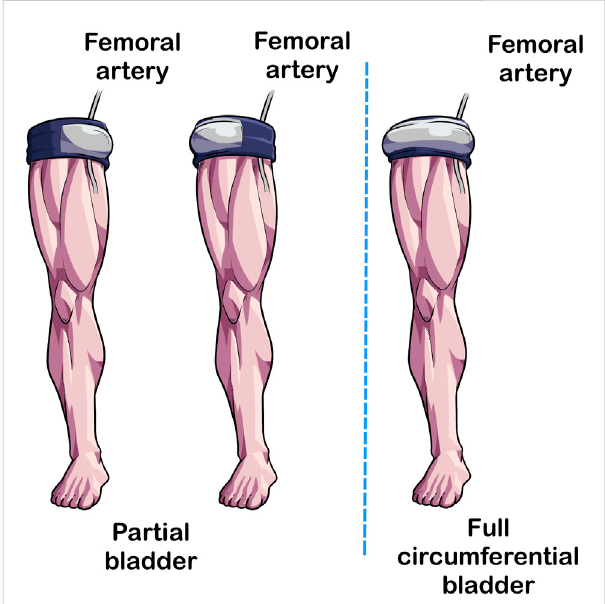
FIGURE 5 Partial circumferential versus circumferential bladder length. In traditional tourniquets, the bladder extends the length of the cuff (Right Image) whereas in some BFR cuffs, the bladder extends partially notcoveringtheentiretyofthelengthofthecuff(LeftandCenter Illustrations). Studies implementing BFR cuffs with partial circumference bladders should specify the position of the bladder because its placement may impact acute responses to BFR